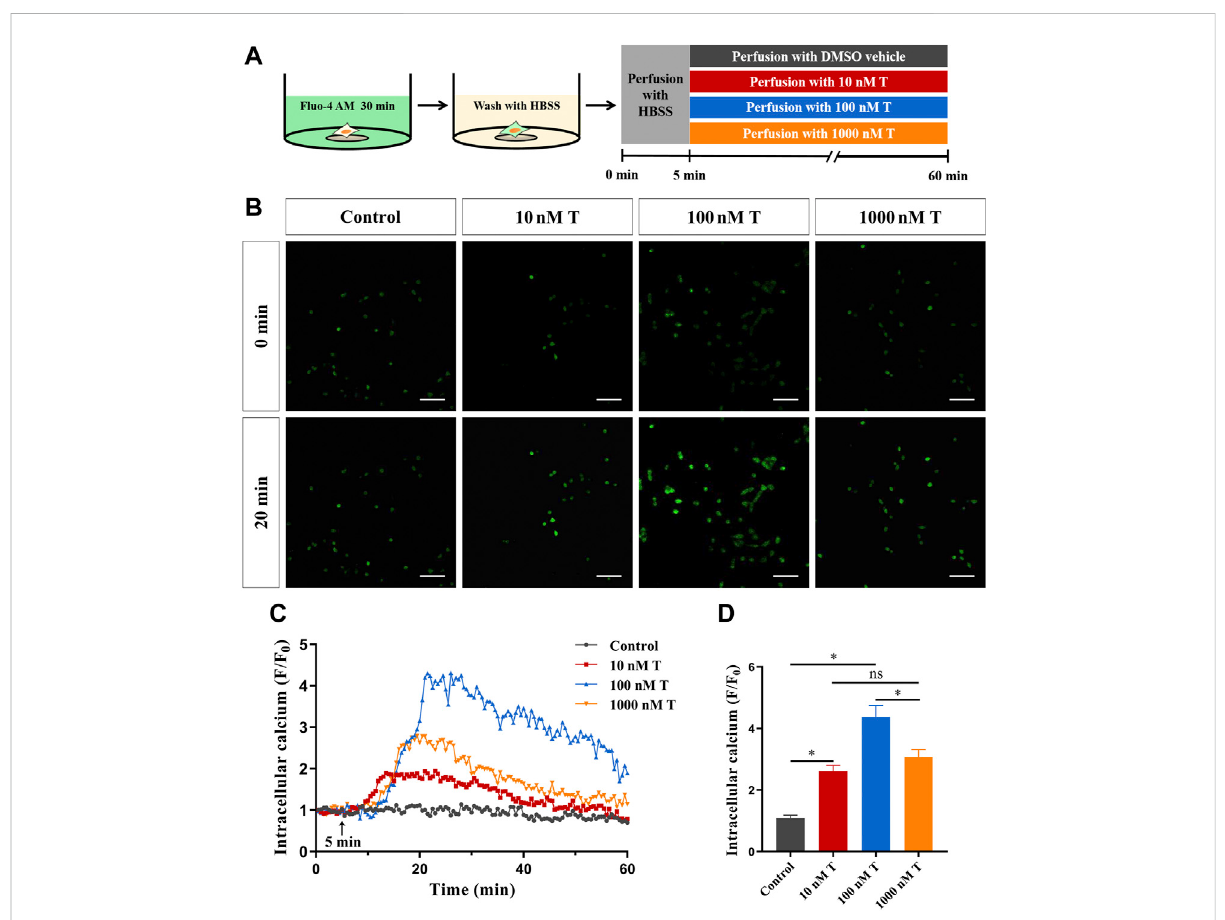
FIGURE 4 Rapid effects ofTon calcium inHT22 cells. (A) Schematicdiagram ofcalcium imaging inthe Tdose-responseexperimentin HT22 cellslabeled with Fluo-4AM. (B) Fluorescence images of T dose-response experiment in Fluo-4AM-labelled HT22 cells. Scale bars = 50 μ m. (C) Representative traces showing the changes in Ca 2+ (F/F0) induced by different doses of T. Black arrows indicate when HT22 cells were treated. (D) Statistical graph showing changes in Ca 2+ (F/F0) induced by different doses of T (ns: non-signi fi cant; * p <